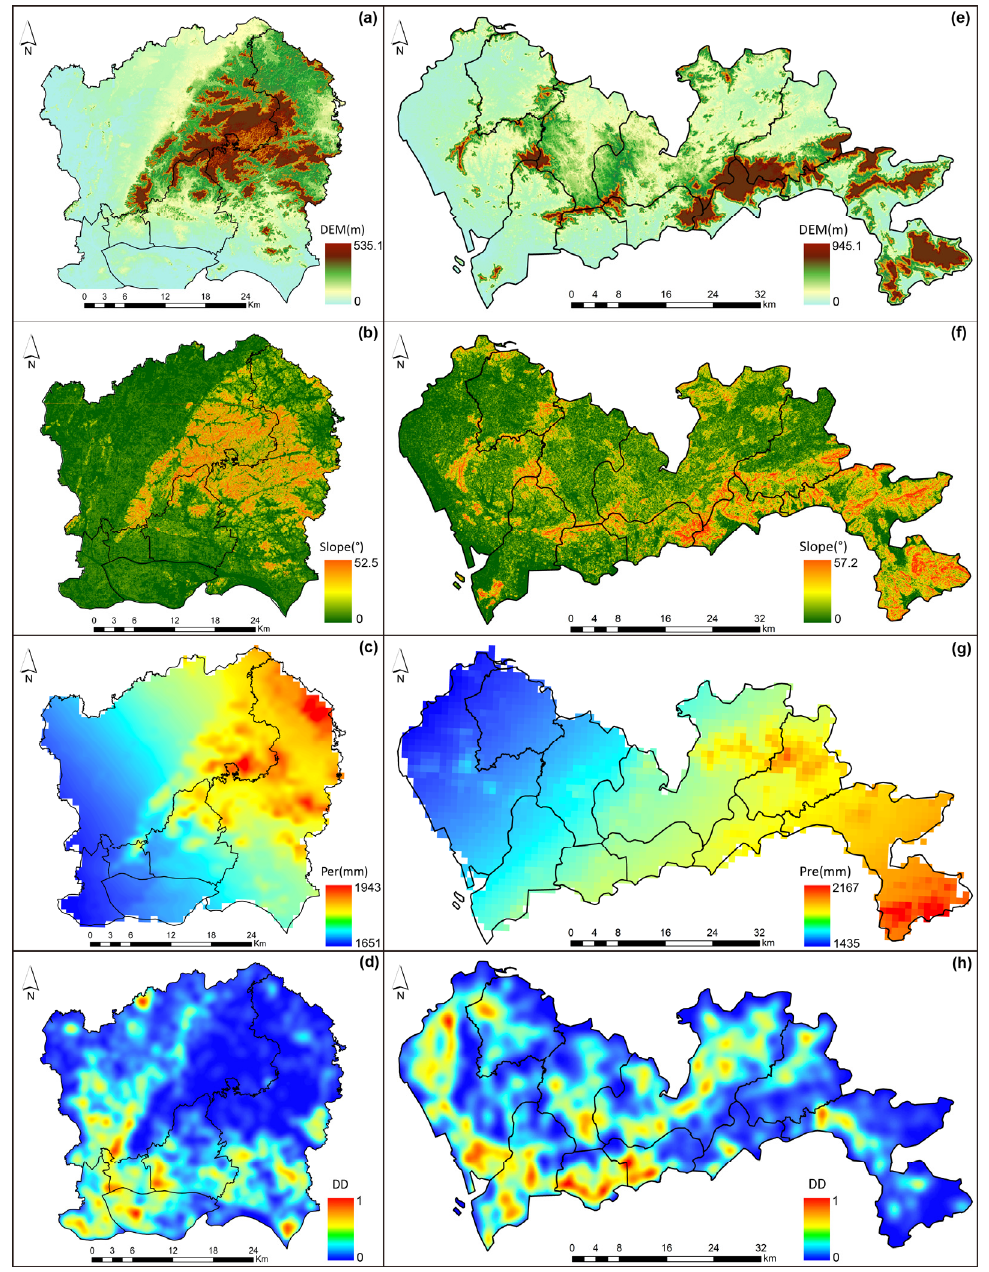
Figure 6. The auxiliary variables for ( a )–( d ) Guangzhou central urban district and ( e )–( h ) Shenzhen.